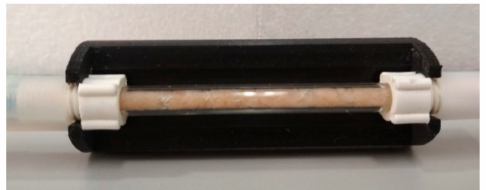
Figure 4. Minicolumn packed with sisal